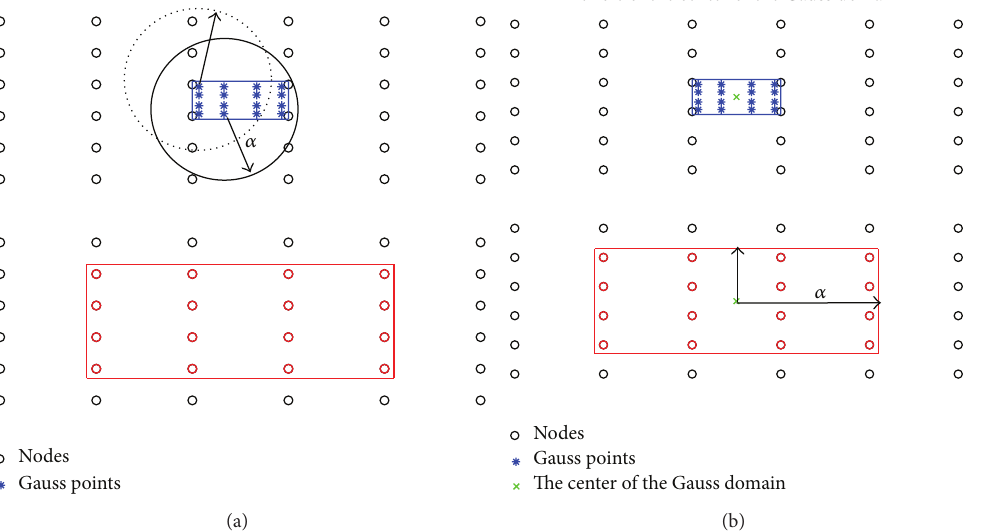
Figure 1: The distribution of the nodes and the Gauss points: find the 1-1 mapping (a); assign the 1-1 mapping